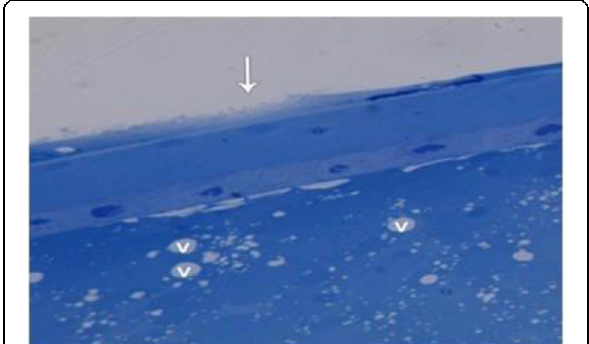
Fig. 13 Light micrograph of rat lens of diabetic model treated with TMAO (group 5) showing discontinuity of lens capsule (arrow), and loss of mitotic figures of lens epithelium with severe vacuolar (V) changes of lens fiber cells (Toluidine blue ×